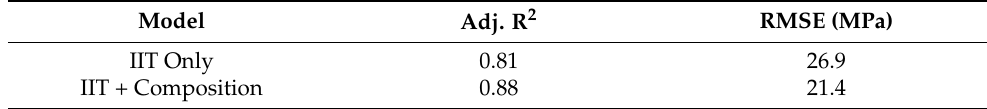
Figure 11. Unity plots comparing estimated versus observed UTS, with 95% confidence interval (gray shaded region) and 95% prediction interval (blue shaded region) for ( a ) IIT alone and ( b ) IIT + composition. Table 4. Comparison of metrics for the UTS models.